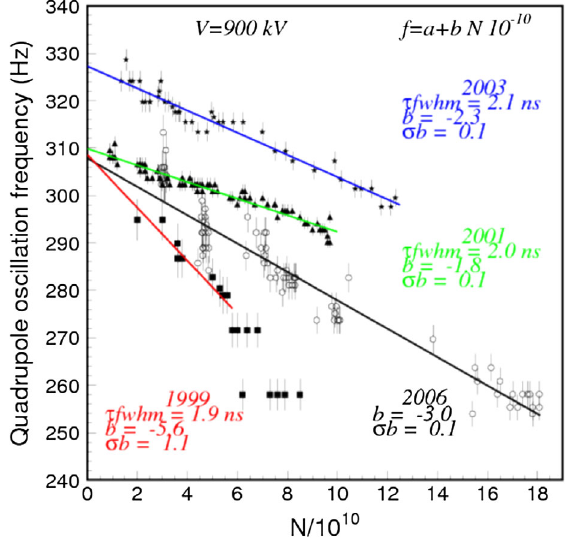
FIG. 3. Measurements of the quadrupole synchrotron frequency shift at 26 GeV = c in the SPS since 1999